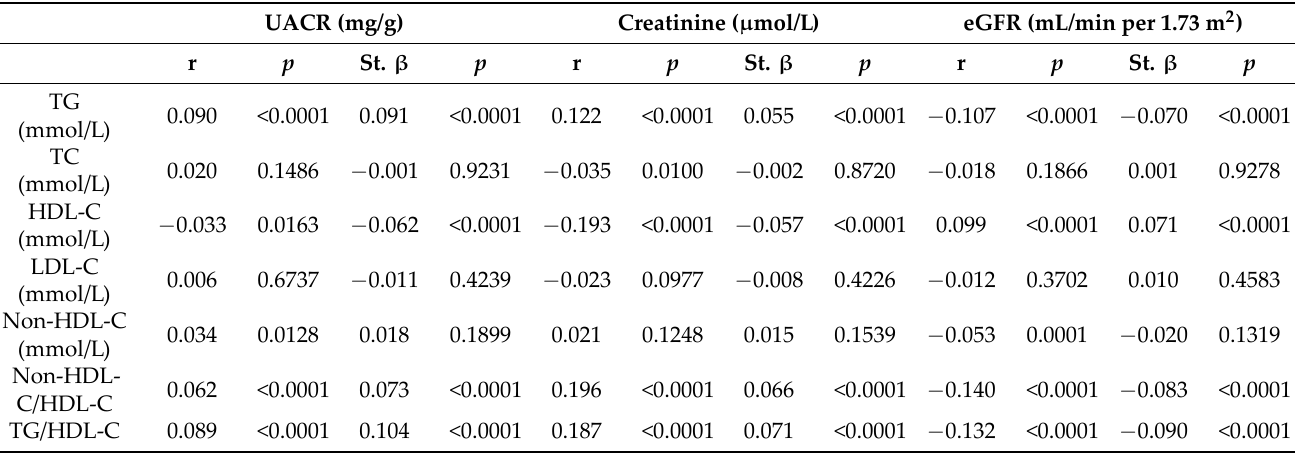
Table 2. Pearson’s correlation and multiple regression analysis of baseline lipid parameters associ‑ ated with UACR, creatinine and eGFR at follow up.